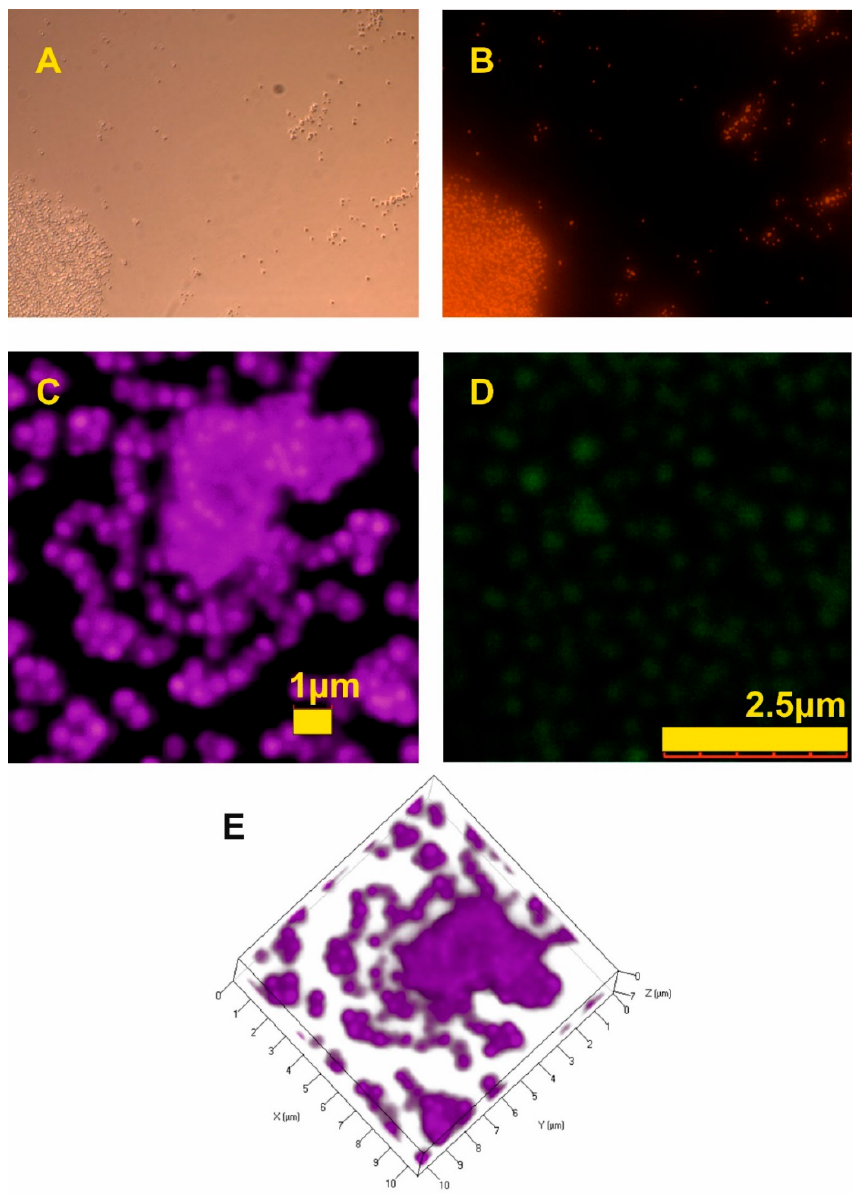
Figure 12. Microscopic images of HFBMA NPs: bright field microscopy ( A ), epifluorescence microscopy ( B ), confocal laser scanning microscopy ( C ), STED ( D ), a 3D picture from CLSM ( E ).